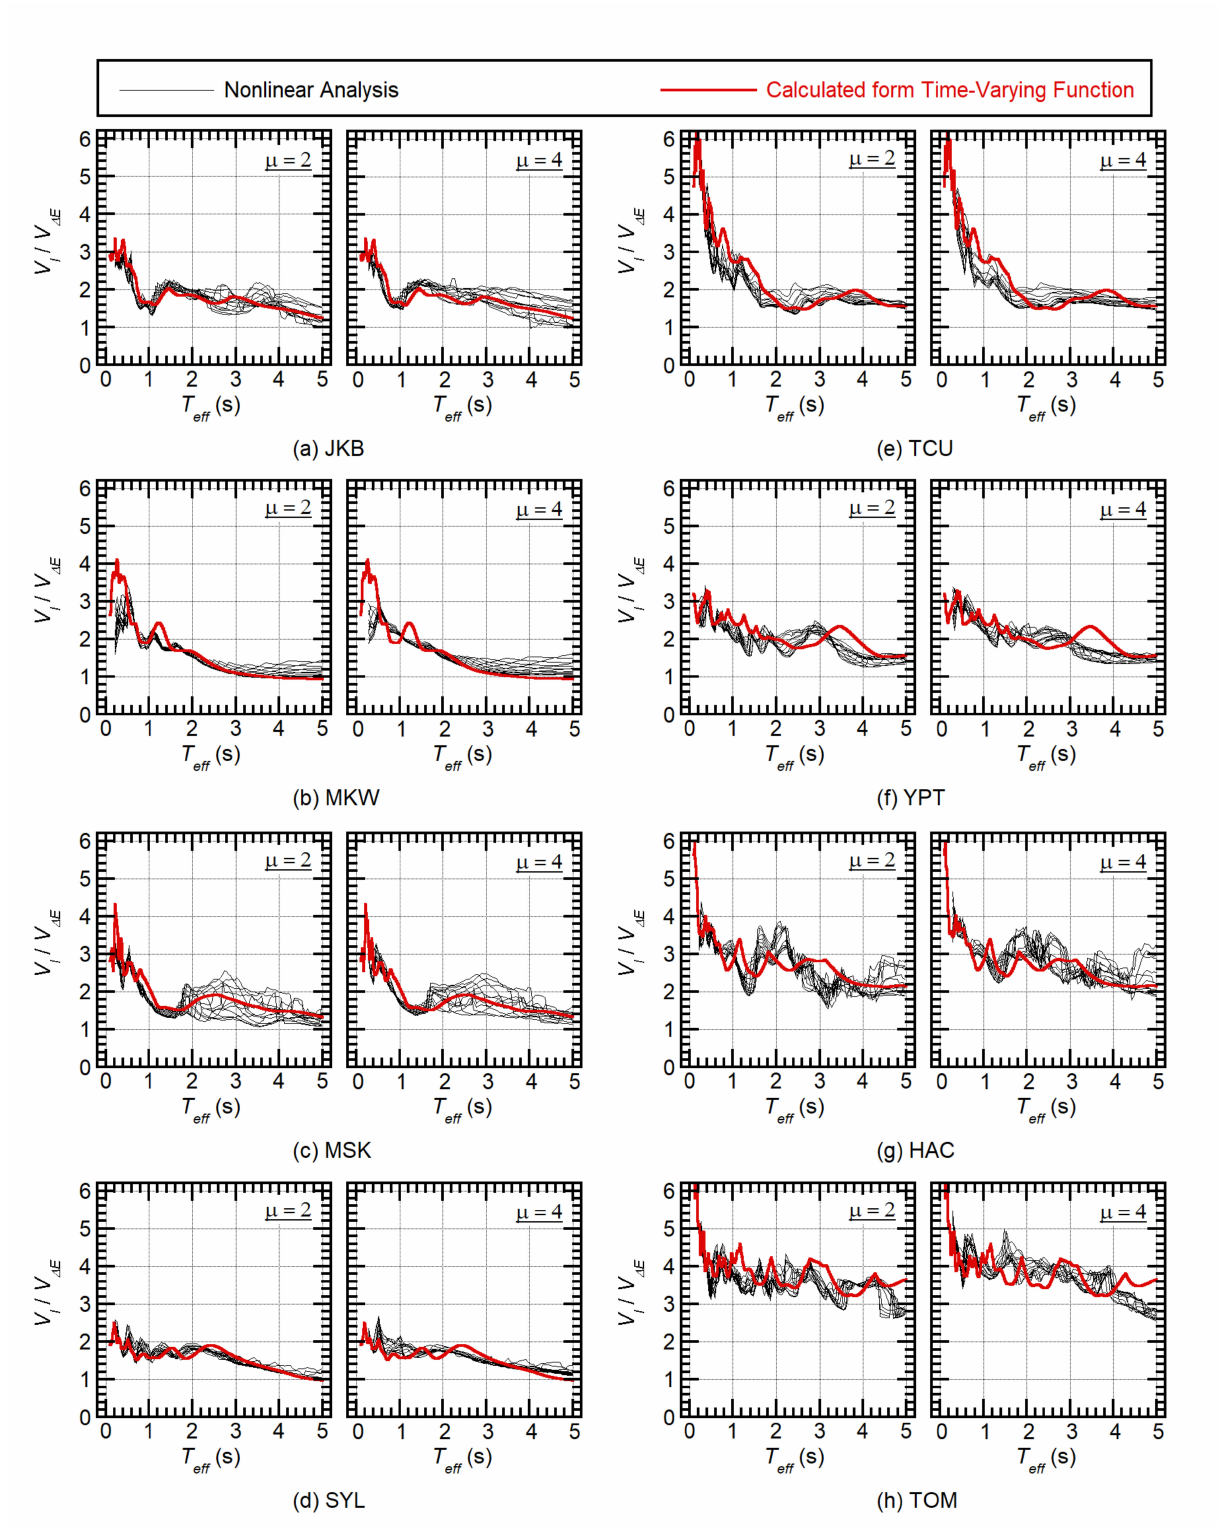
Figure 14. Evaluation of the V I / V ∆ E ratio for each ground acceleration group. From the comparisons between Equation (18) and Equations (32)–(35), the following observations can be